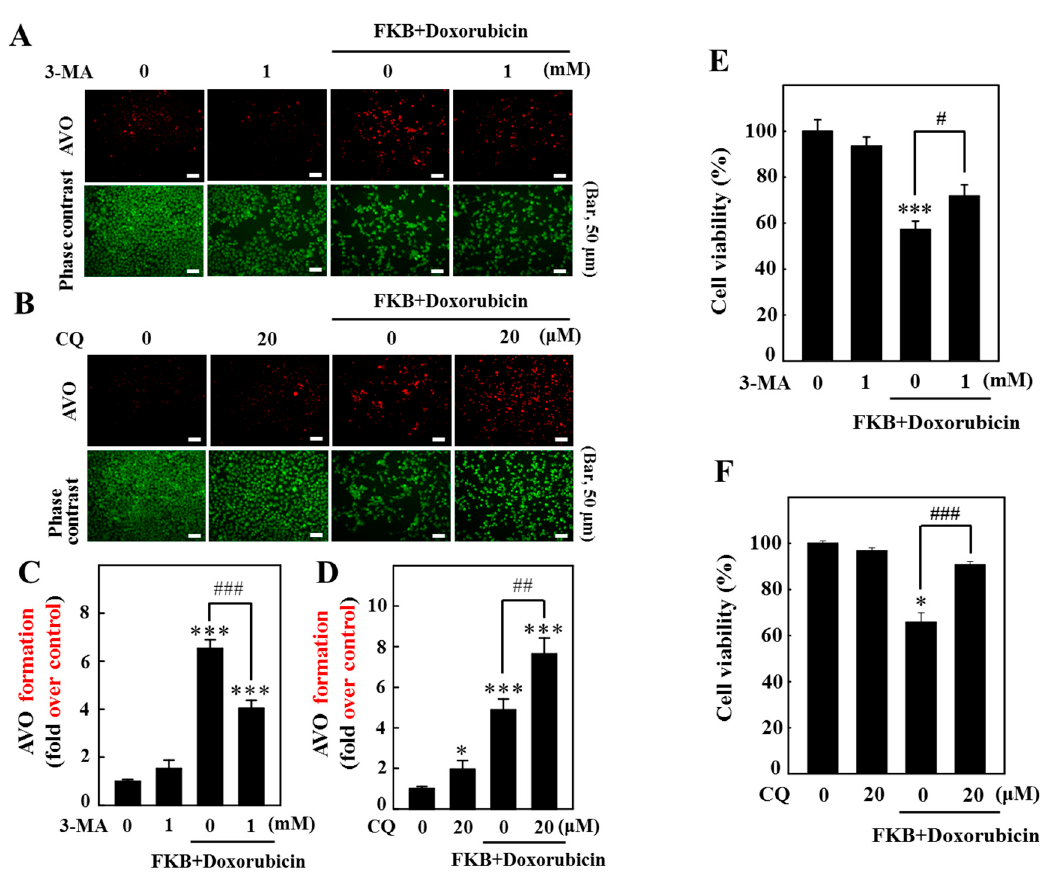
Figure 5. Pharmacologic autophagy inhibitors on FKB increase the formation of AVO triggered by doxorubicin in AGS cells. Cells were pretreated for 1 h with autophagy inhibitors (3-MA, 1 mM, and CQ, 20 µ M), followed by a 24-h co-treatment with FKB (2.5 µ g / mL) and doxorubicin (0.5 µ g / mL). ( A , B ) The orange acridine (AO) was used to stain the AVOs. ( C , D ) Visualization of AVO formation in cells under a red filter fluorescence microscope (100 × magnification). Red intensity of the fluorescence is proportional to the number of AVOs in cells. Number of stained AO cells was presented as histograms, with a control as 1.0-fold. ( E , F ) Autophagy triggered by FKB + doxorubicin which signaled cascades as a cell death mechanism. MTT trial determined cell viability. Values were expressed as mean ± SD ( n = 3). Significant at * p < 0.05; *** p < 0.001 compared to untreated control cells. Significant at # p < 0.05; ## p < 0.01; ### p < 0.001 compared to FKB + doxorubicin-treated cells.